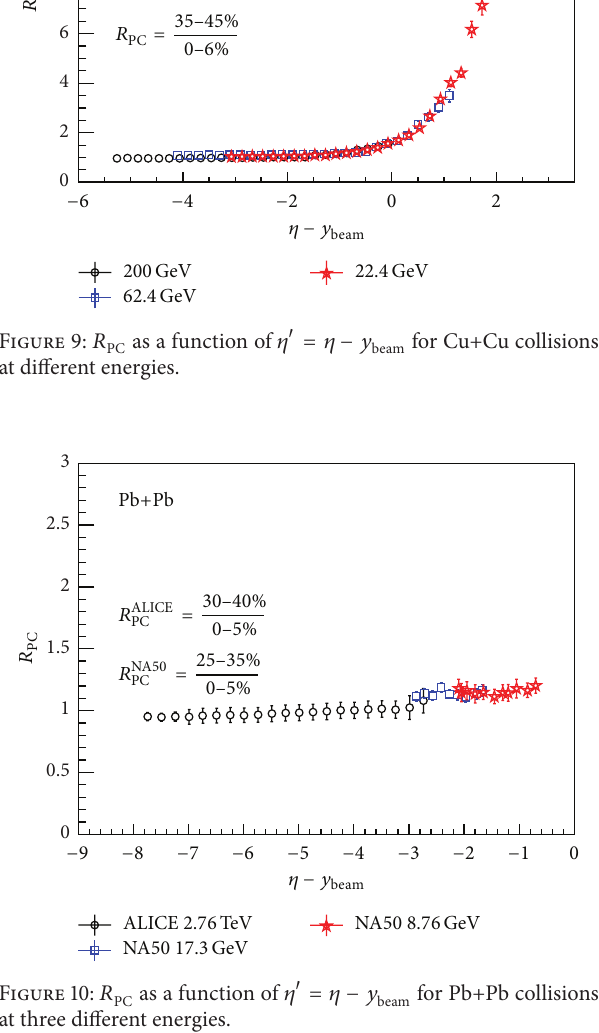
for Pb+Pb collisions beam